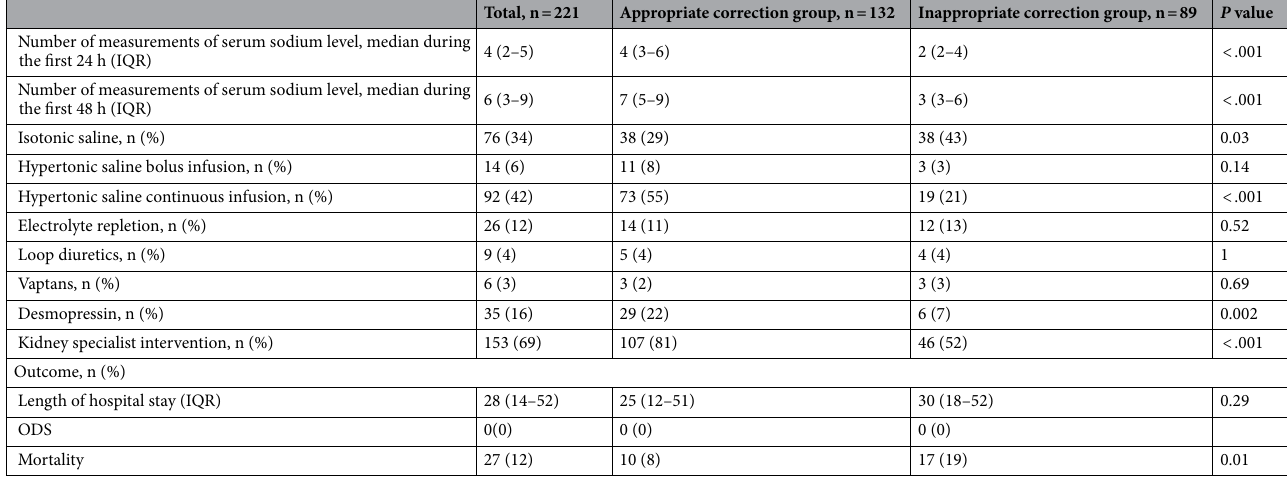
Table 1. Baseline characteristics and outcomes of all patients, the appropriate correction, and inappropriate correction group with the serum sodium concentration ≤ 120 mEq/L. IQR interquartile range; BP blood pressure; eGFR estimated glomerular filtration rate; SIADH syndrome of inappropriate secretion of antidiuretic hormone; NSAIDs non-steroidal anti-inflammatory drugs; SSRI selective serotonin reuptake inhibitors; ODS osmotic demyelination syndrome Categorical variables are shown as numbers (percentages) and continuous variables as medians (25–75 percentiles) P values represent a significant difference between appropriate and inappropriate correction